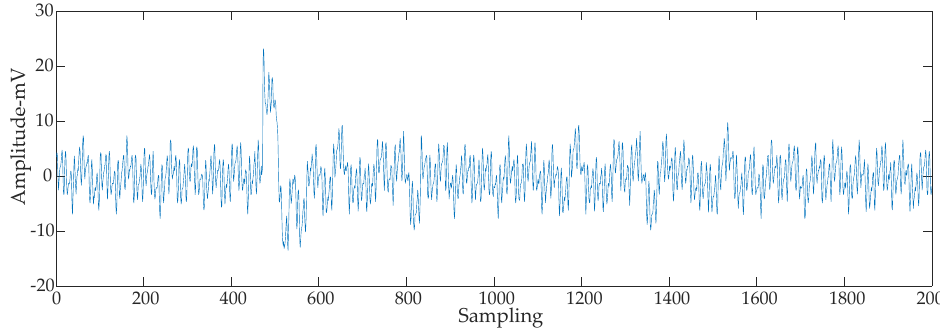
Figure 17. Laboratory measurement signal with DC component removed.